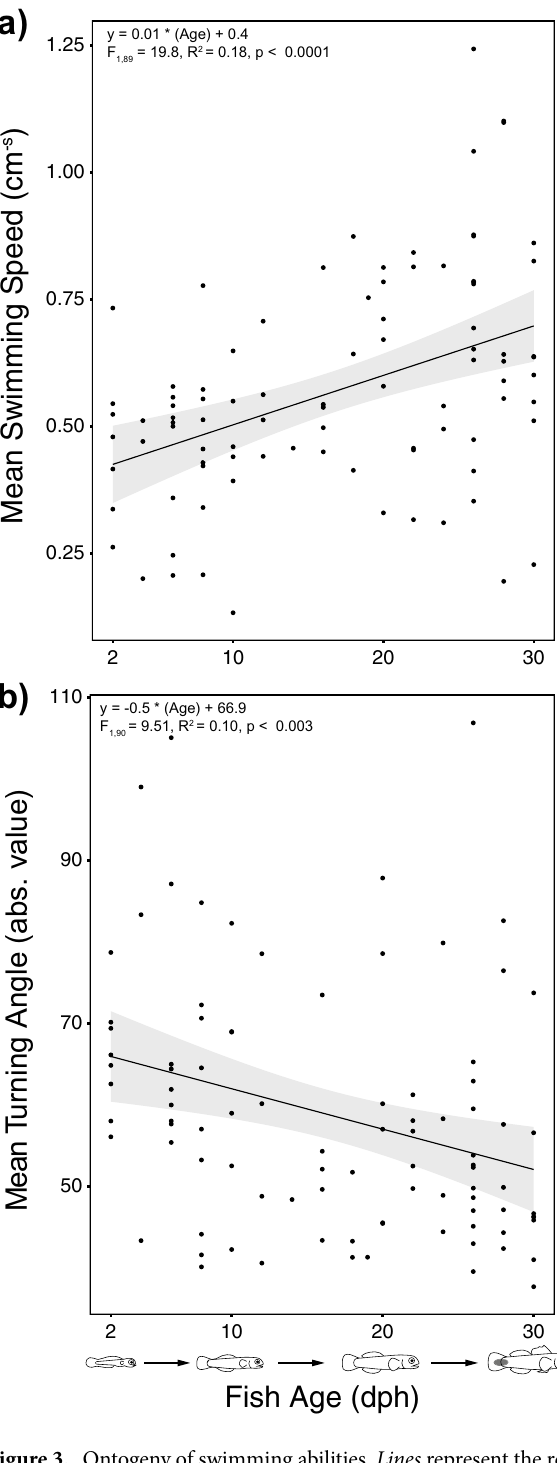
Figure 3. Ontogeny of swimming abilities. Lines represent the relationship of fish age to ( a ) mean swimming speed, and ( b ) mean turning angle measured from E. lori larvae deployed in the DISC. Shaded regions represent the 95% confidence